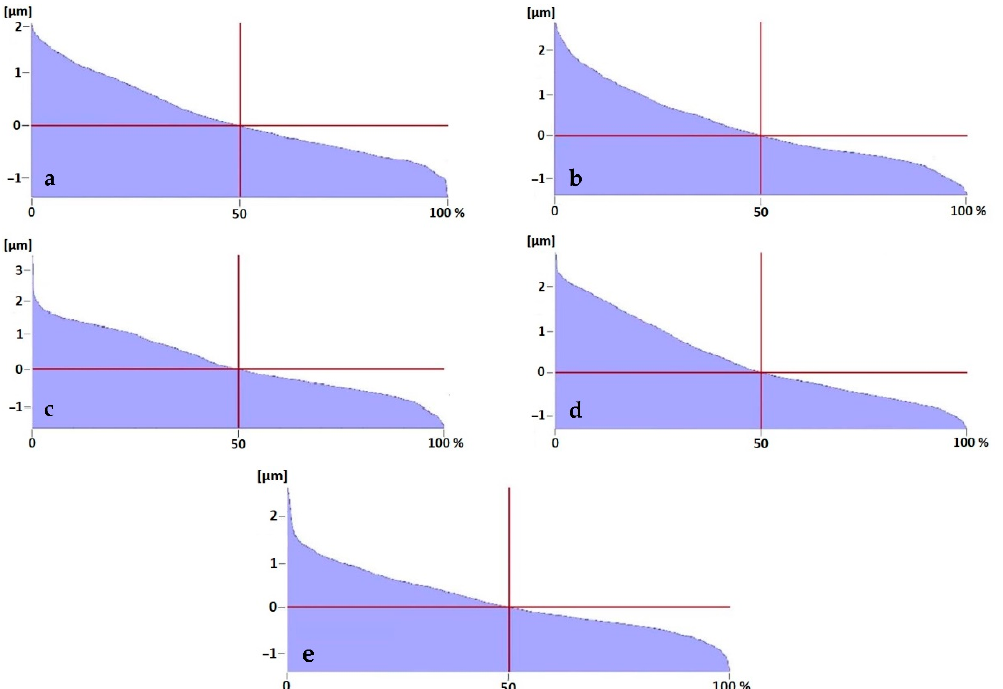
Figure 6. Bearing area curves for the surfaces processed with the T1–T5 tools with feed f 1 = 0.1 mm/rev.: ( a ): T1; ( b ): T2; ( c ): T3; ( d ): T4; ( e ): T5.